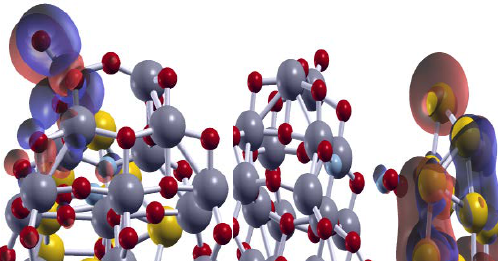
Fig. 11. The isosurfaces of HOMO and LUMO molecular orbital of the NO 2 molecule adsorbed on the TiO 2 /Gold nanocomposites